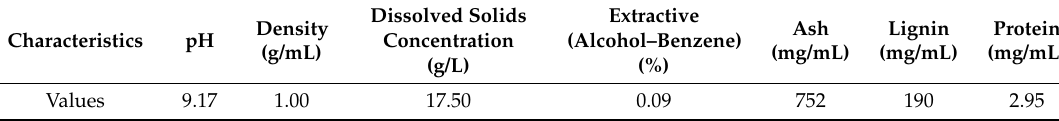
Table 2. Chemical composition of pulping